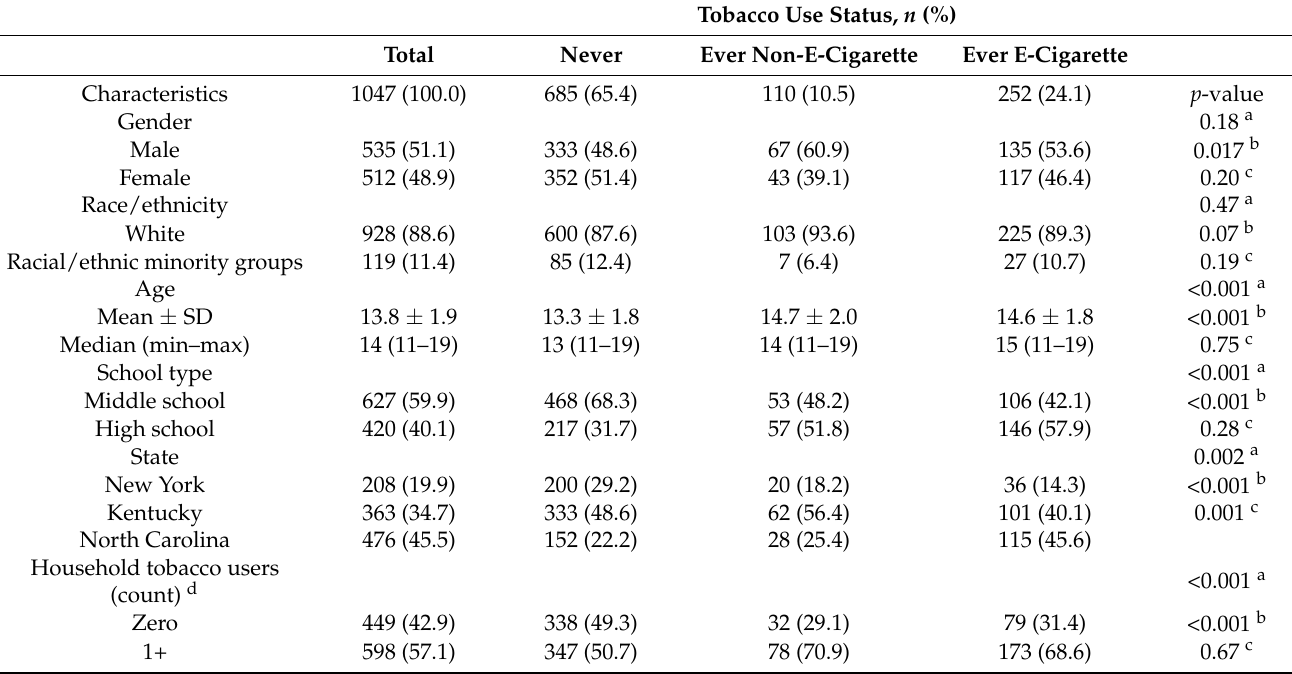
Table 1. Participant Characteristics by Tobacco Use Status, The Youth Appalachian Tobacco Study ( n = 1047).